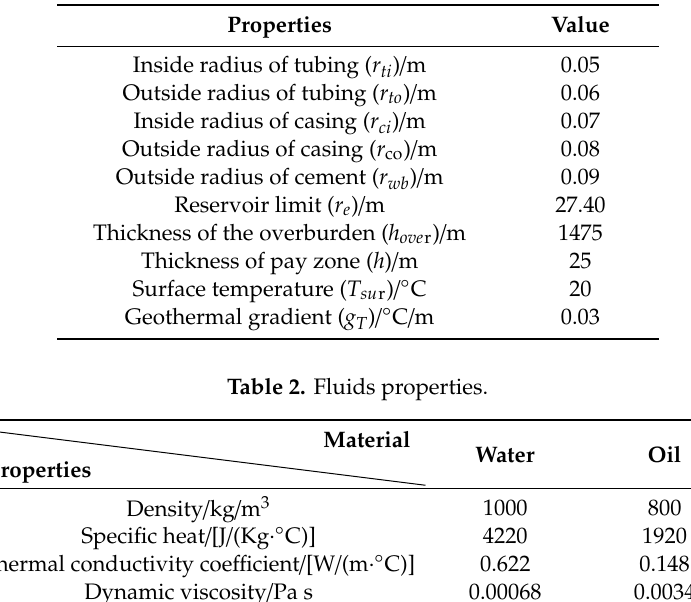
Table 1. Downhole geometry and ambient temperature.